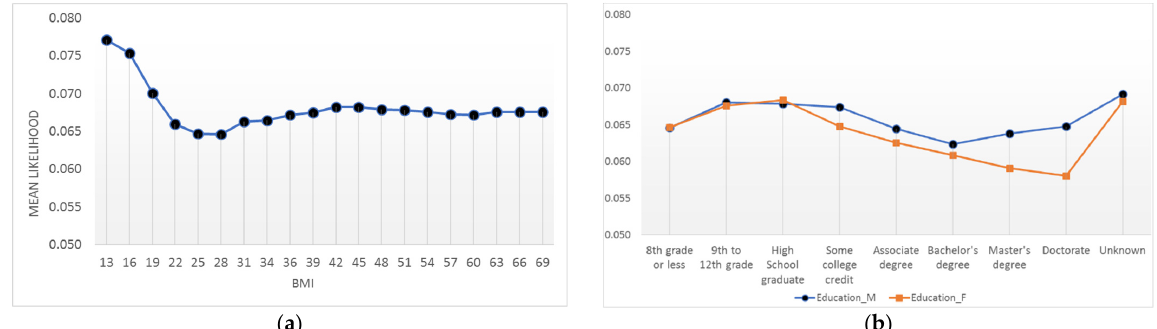
Figure 8. Partial dependence plot for BMI and parent’s education: ( a ) preterm delivery likelihood for different values of BMI; ( b ) preterm delivery likelihood for different levels of education.